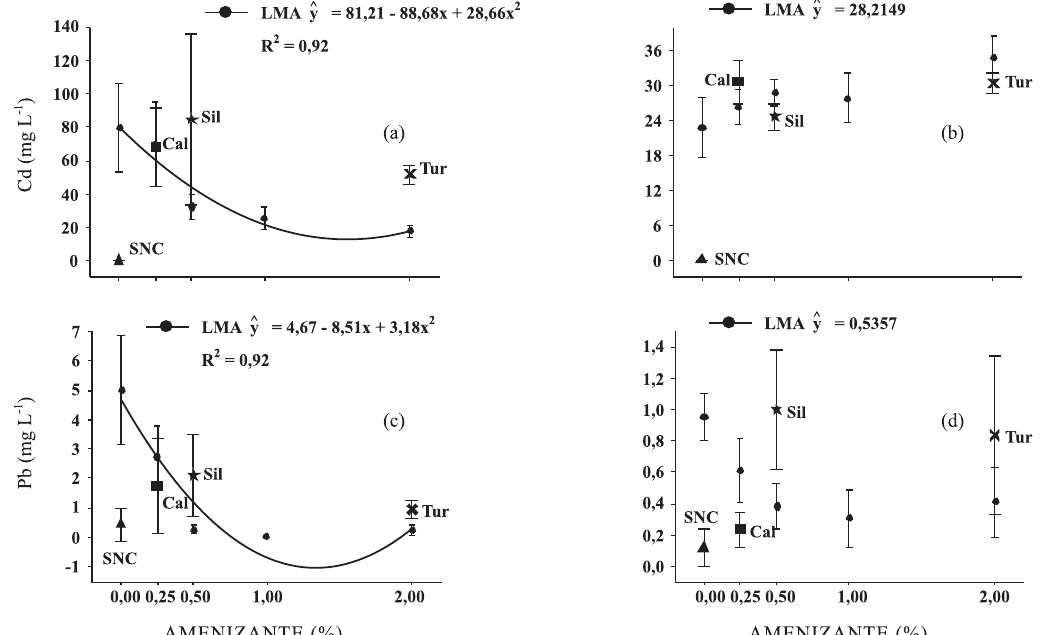
Figura 6. Concentração de Cd e de Pb na matéria seca da parte aérea (MSPA) de Brachiaria decumbens (mg kg -1 ), respectivamente, no Neossolo Quartzarênico (a e c) e no Latossolo Vermelho (b e d) contaminados com Cd e Pb. LMA: lama da mineração de Al, SNC: solo não-contaminado, Cal: calcário, Sil: silicato e Tur: